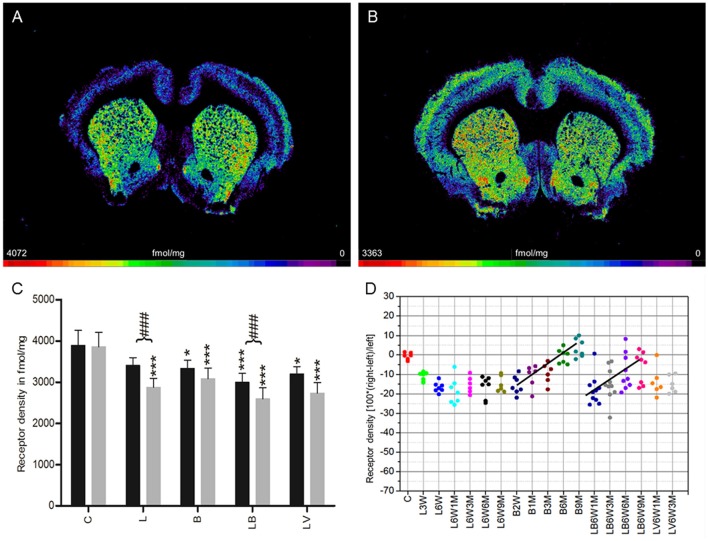
(A,B) Contrast-enhanced color-coded images showing the regional distribution of M2 and M4 receptor densities receptor density labeled with the antagonist [3H]AF-DX 384 in a control rat (A,B) after 6-OHDA lesion (group L6W6M) in a control rat (A) and after 6-OHDA lesion (group L6W6M) (B). (C) Mean receptor density (fmol/mg protein; averaged over all post-lesion survival times) in the left/contralateral (black column) and right/ipsilateral hemispheres (gray column) of the five groups (see Figure 1). All data is expressed as means ± SD. Asterisks mark significant differences to the respective side of controls (*p < 0.05, ***p < 0.001). Rhombs signs highlight interhemispheric significance within each group (###p < 0.001). (D) Scatter plots and regression analyses of the right-left differences of M2 receptor density for all 18 groups and time points (five groups with different survival times); see Table 1 for explanation of abbreviations. Significant regressions are labeled by a continuous line.